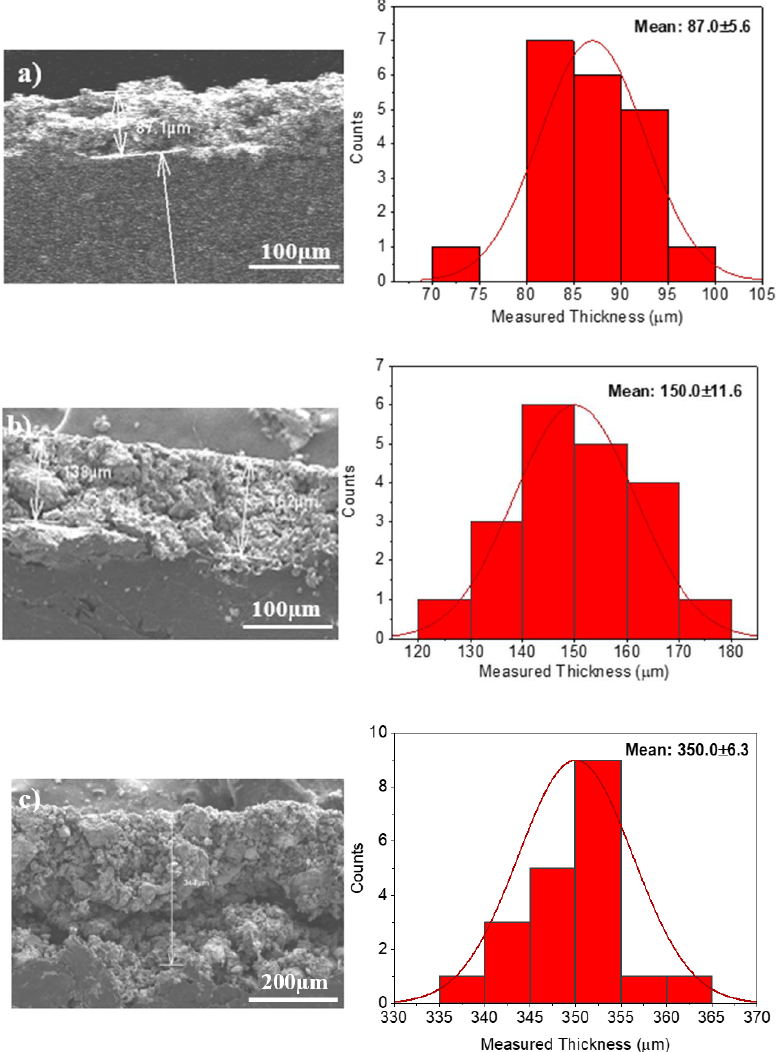
Figure 4. SEM images of cross-section and histograms showing the distribution of measured thickness of electrodes of an initial thickness of the wet film of ( a ) 200 μ m, ( b ) 400 μ m and ( c ) 600 μ m.